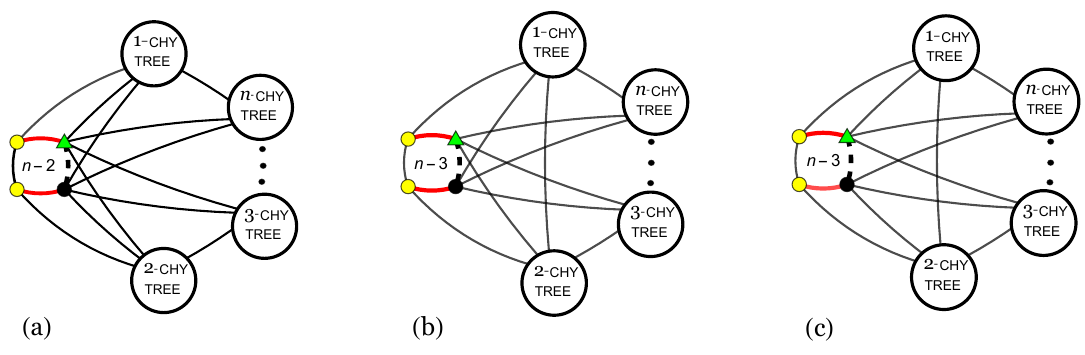
Figure 4 . Fundamental CHY-Integrands at one-loop.